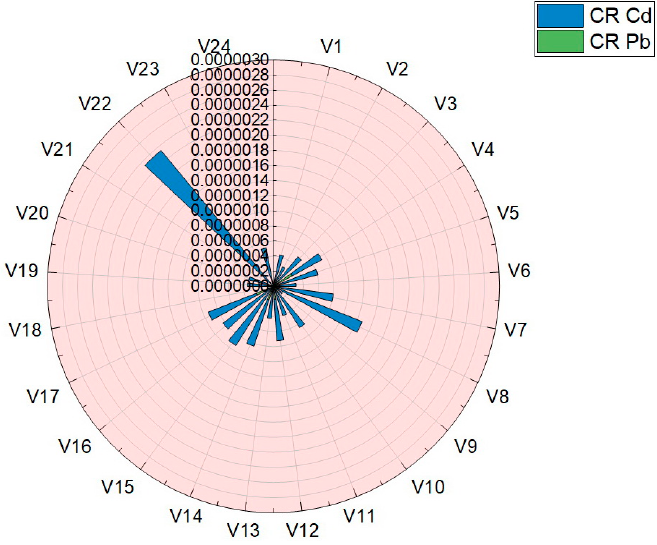
Figure 10. Graphical representation of the results obtained for carcinogenic risk (CR) in the case of Pb and Cd.